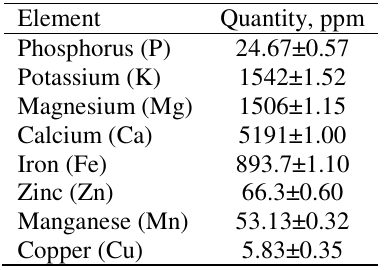
Table 2. Mineral composition of E.